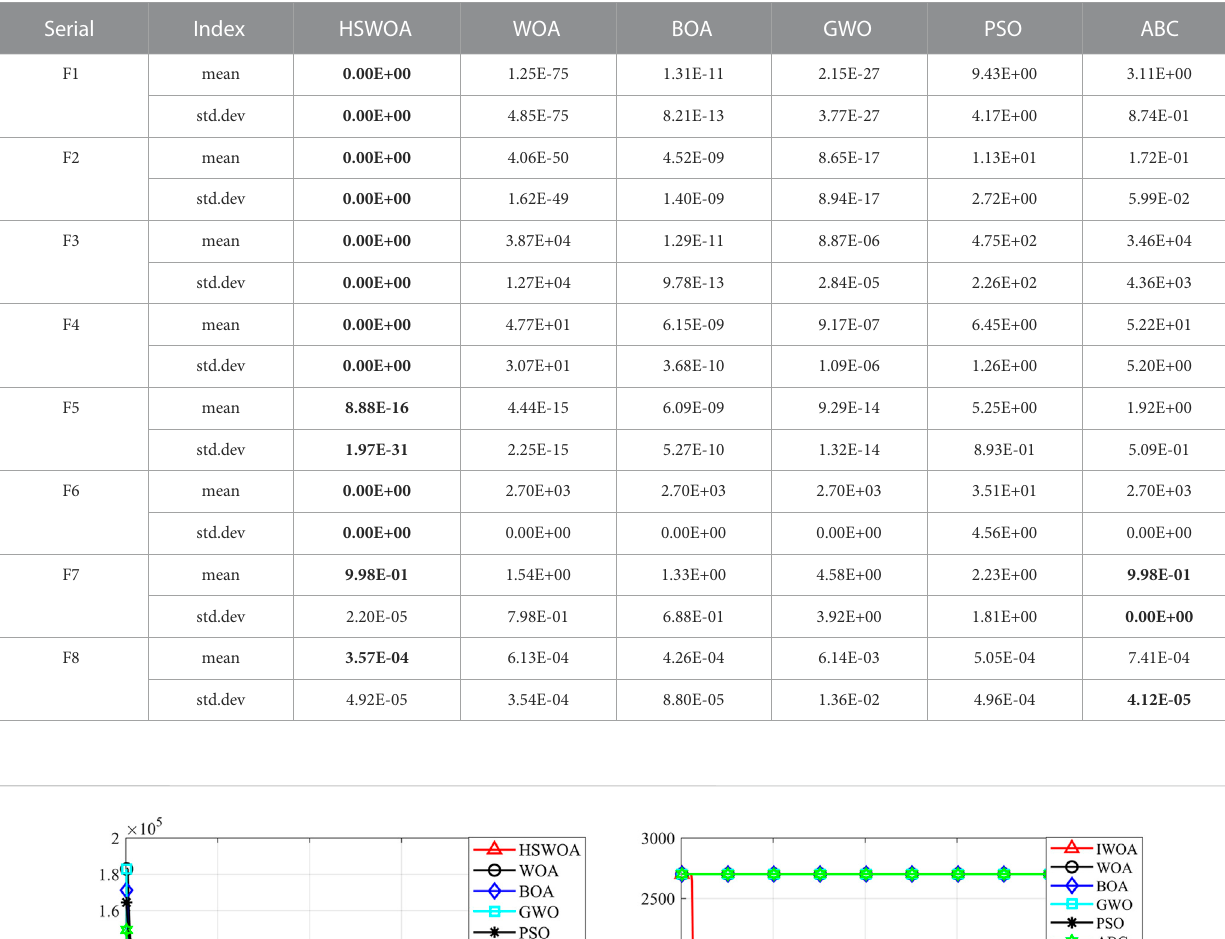
TABLE 1 Algorithm performance test results.